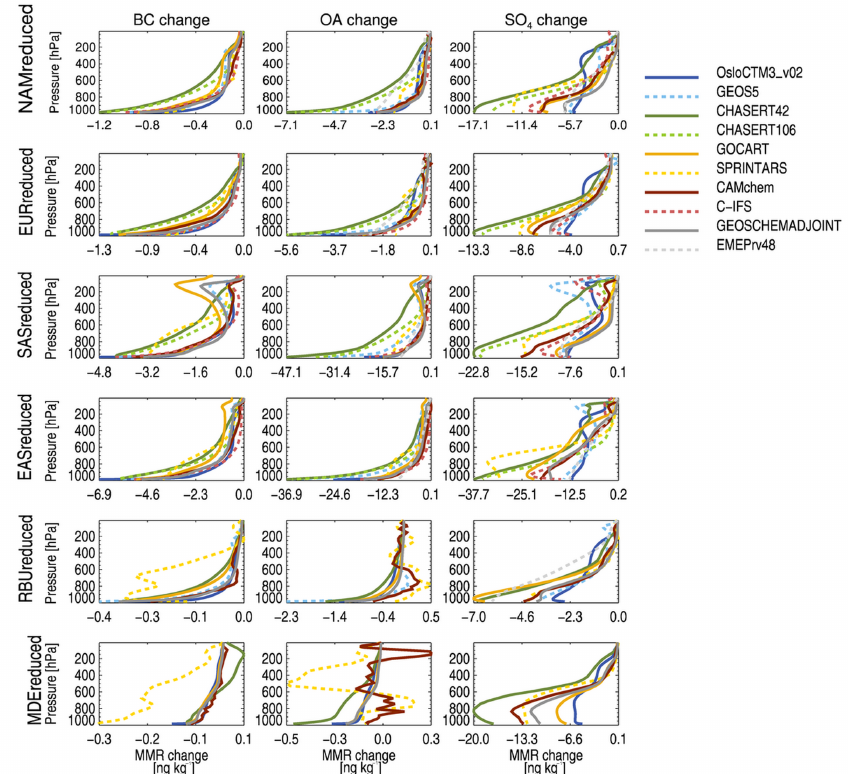
Figure 4. Globally averaged change in MMR per model layer, when reducing emissions by 20% within the region indicated (rows), for all aerosol species (columns). Each line represents one model. See Tables S2 to S4 in the Supplement for the total burden changes for all models, experiments and